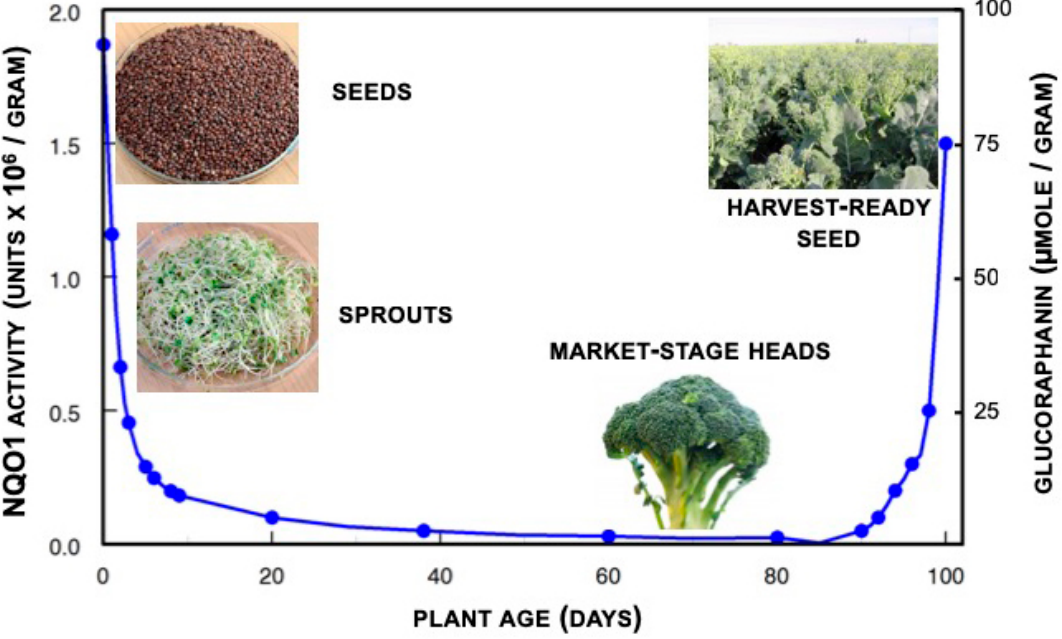
Figure 1. On a weight basis, glucoraphanin ( right axis ) is most abundant in the seeds of the broccoli plant. Upon enzymatic conversion to sulforaphane, the capacity of extracts of these plants to induce or up-regulate phase 2 enzymes such as NQO1 in mammalian cells, follows precisely the same curve ( left axis ).